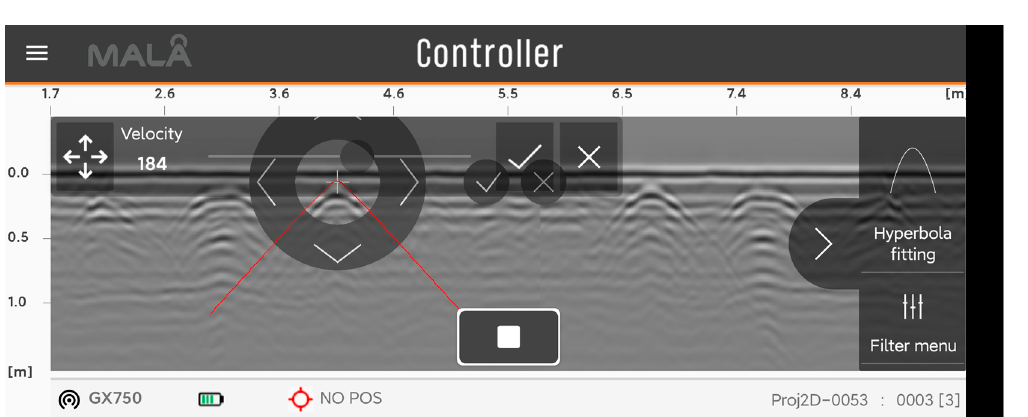
Figure 20. Quickly obtained propagation speed of electromagnetic waves in this medium.